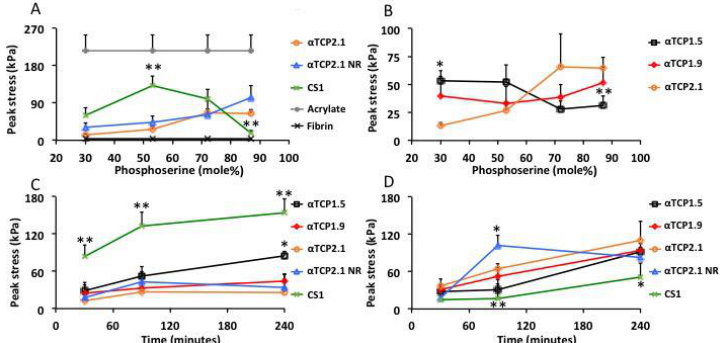
Figure 6. Lap shear strength of PMCs. ( A ) The optimal bond strength of PMCs, with varied ratio of calcium salt to phosphoserine, after curing for 90 min. ( B ) The optimal bond strength of αTCP PMCs of differing particle size, with varied ratios of calcium salt to phosphoserine after curing for 90 min. To ensure that the comparisons in ( A ) and ( B ) represented the true final cure strength, the cure kinetics of each PMC was compared at the optimal mole ratio for ( C ) CS1 PMC (53%) and ( D ) αTCP PMC (87%) after curing for 30, 90, or 240 min. αTCP1.5, αTCP1.9, and αTCP 2.1 refer to the average particle sizes (D0.5, surface, in micrometers) of the calcium salt portion of PMC. * and ** indicate p < 0.05 and p < 0.01, respectively, with all comparisons made against αTCP 2.1 PMC with respect to each time point or mole ratio. Each data point and group represents a sample size of six ( n = 6) in Figure 6A – D.